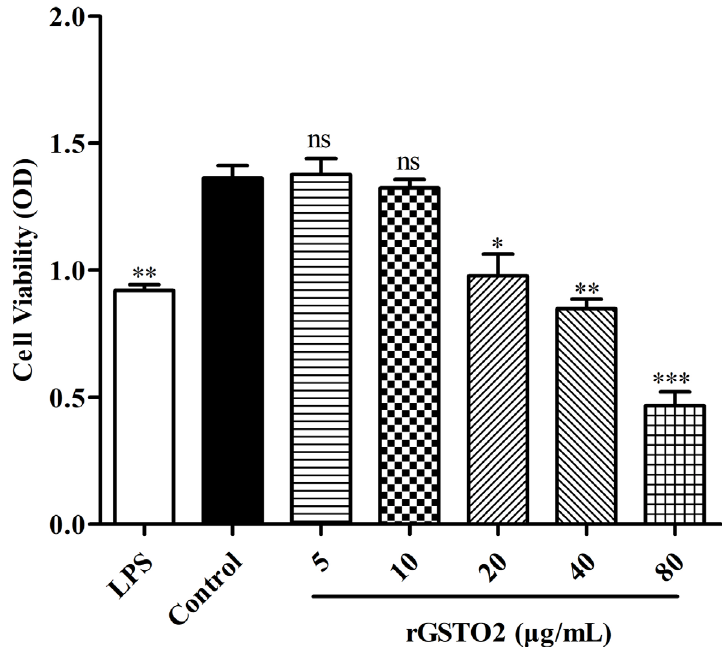
Figure 5. Viability assay of RAW264.7 macrophages stimulated by rGSTO2 protein in vitro. Macrophages treated with LPS or PBS were used as positive or negative controls, respectively and the cells were treated with rGSTO2 protein at different concentrations (5 – 80 l g/mL) for 24 h, and then the cell viability was measured by a CCK-8 assay. Ns means that the difference is not signi fi cant, ** p < 0.01 and *** p < 0.001 versus the negative control. All data are expressed as means ± SD ( n =